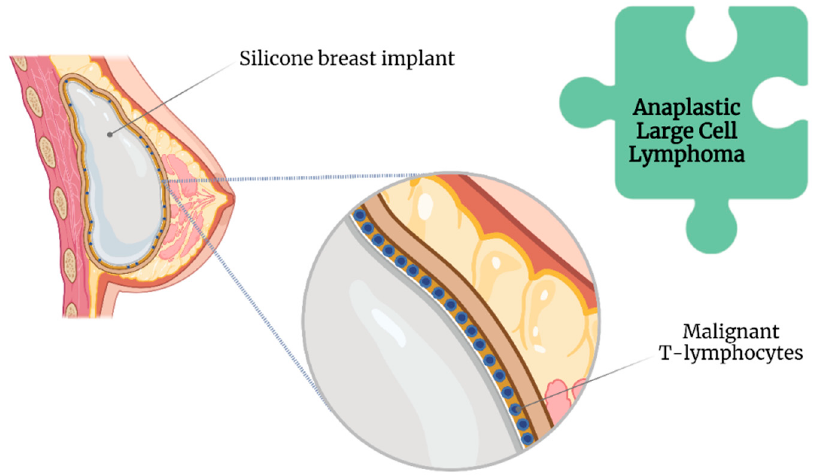
Figure 3. Association of anaplastic large cell lymphoma with breast implant illness.